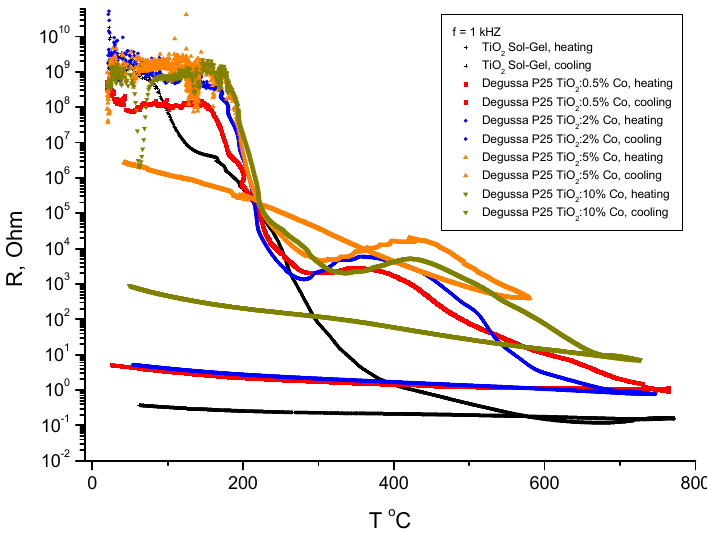
Figure 8. Electrical resistance of the Co–doped TiO 2 samples on heating and on cooling.